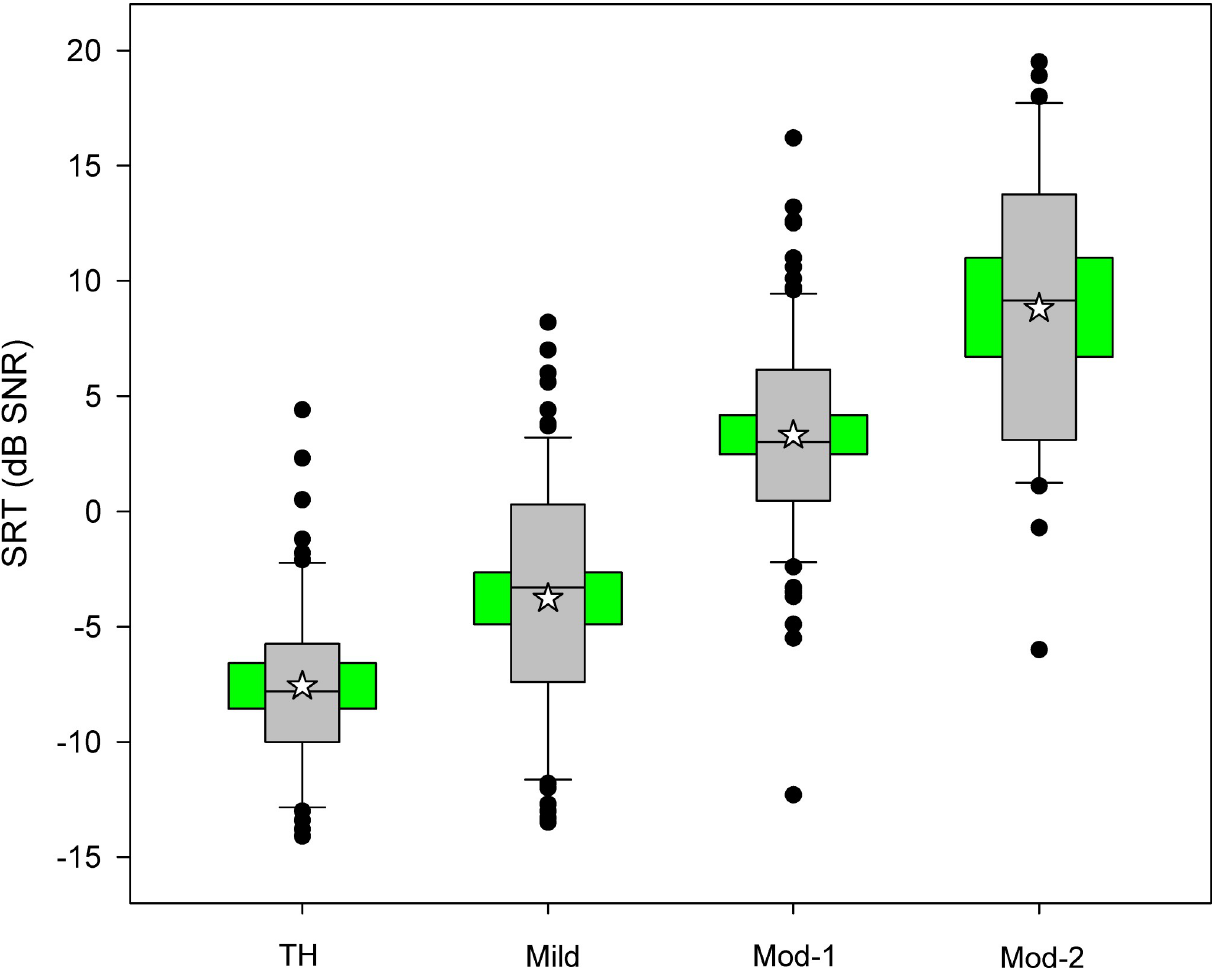
Fig 2. Boxplots of SRTs in diffuse noise for each hearing group. The grey boxes show the 25 th and 75 th percentile, the error bars show the 10 th and 90 th percentiles, the circles show outliers, the horizontal lines in the box show the median, the white stars show the mean, and the green boxes show the 95% confidence